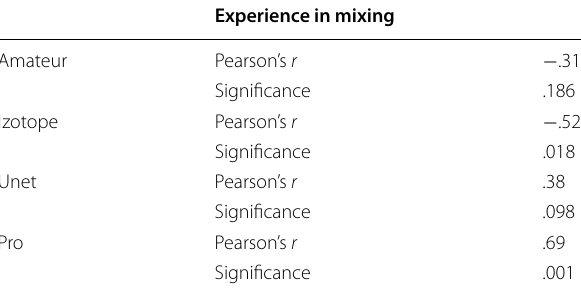
Table 5 Correlation between the experience in mixing and the overall ratings of mixes Experience in